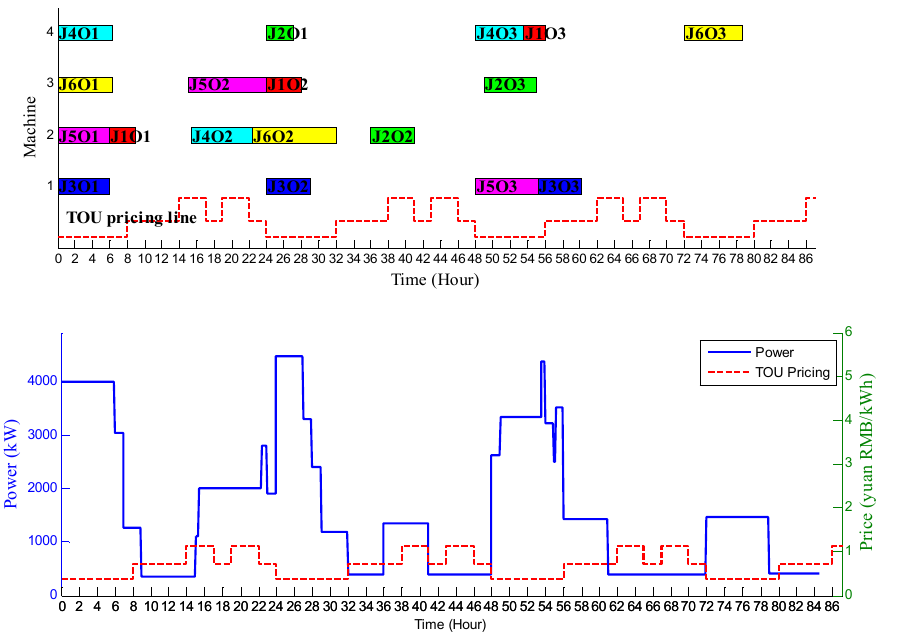
Figure 12. Gantt and power charts of the optimal solution to configuration C4 × 6&PDF.